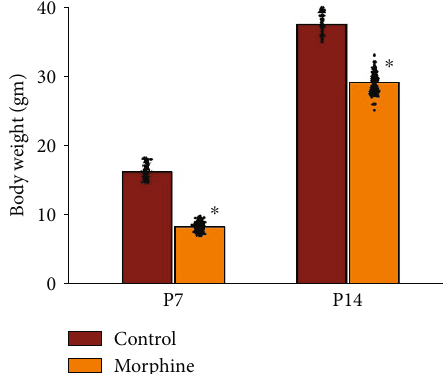
Figure 1: The BW of rat o ff spring of the prenatally opioid-exposure group was statistically signi fi cantly lower. The BW of rat o ff spring on P7 was as follows: the control group: 16 : 3 ± 1 : 3 g ( n =48 rats) vs. the prenatally opioid-exposure group: 8 : 3 ± 0 : 7g ( n = 96 rats). And the BW of rat o ff spring on P14 was as follows: the control group: 37 : 6 ± 1 : 7 ( n =48 rats) vs. the prenatally opioid-exposure group: 29 : 2 ± 1 : 6g ( n = 96 rats). Scatted dots represent the data points in each group. ∗ p < 0 : 05 , compared to the control